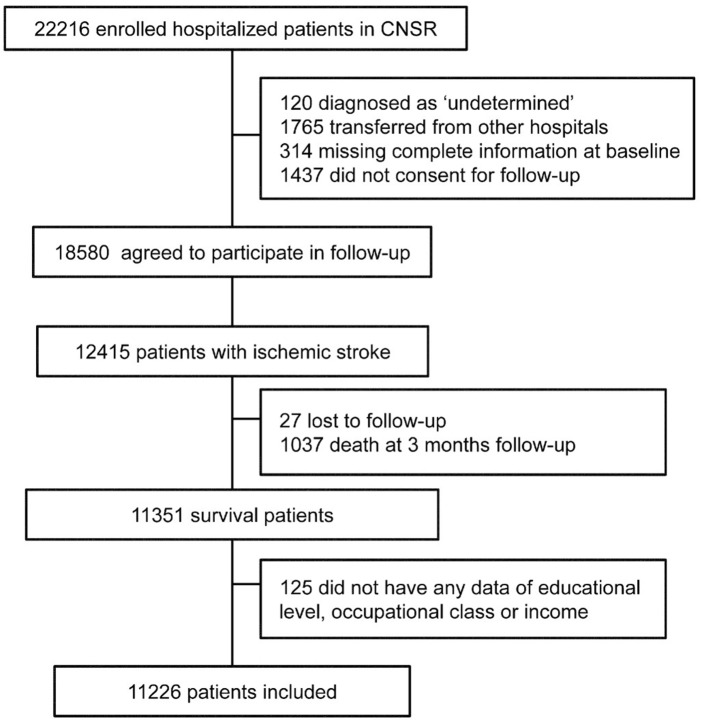
Flow diagram of participants.